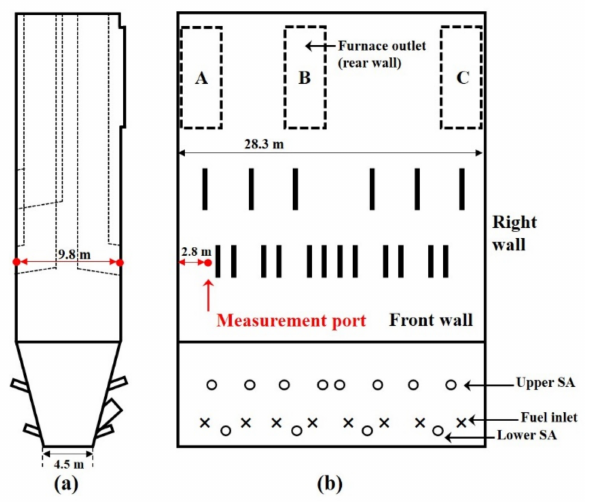
Figure 3. Positions of the horizontal measurement ports in the dilute phase: ( a ) view from the side wall; and ( b ) view from the front wall.